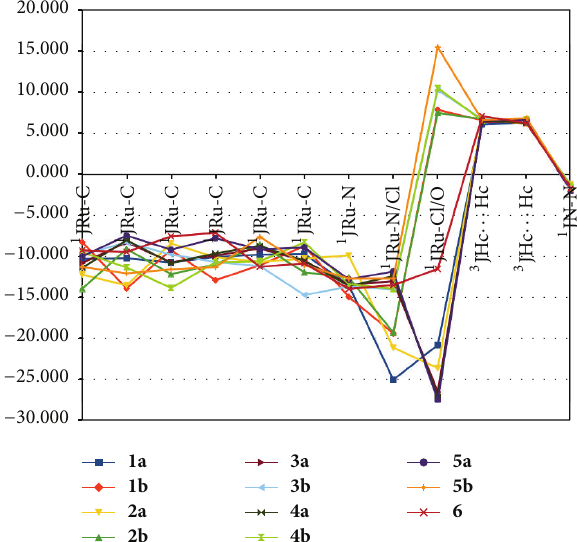
Figure 3: Features of changes in the selected spin-spin coupling of ruthenium(II) 𝜂 6 -cymene complexes of dimethylpyrazole deriva- tives and their hydrated